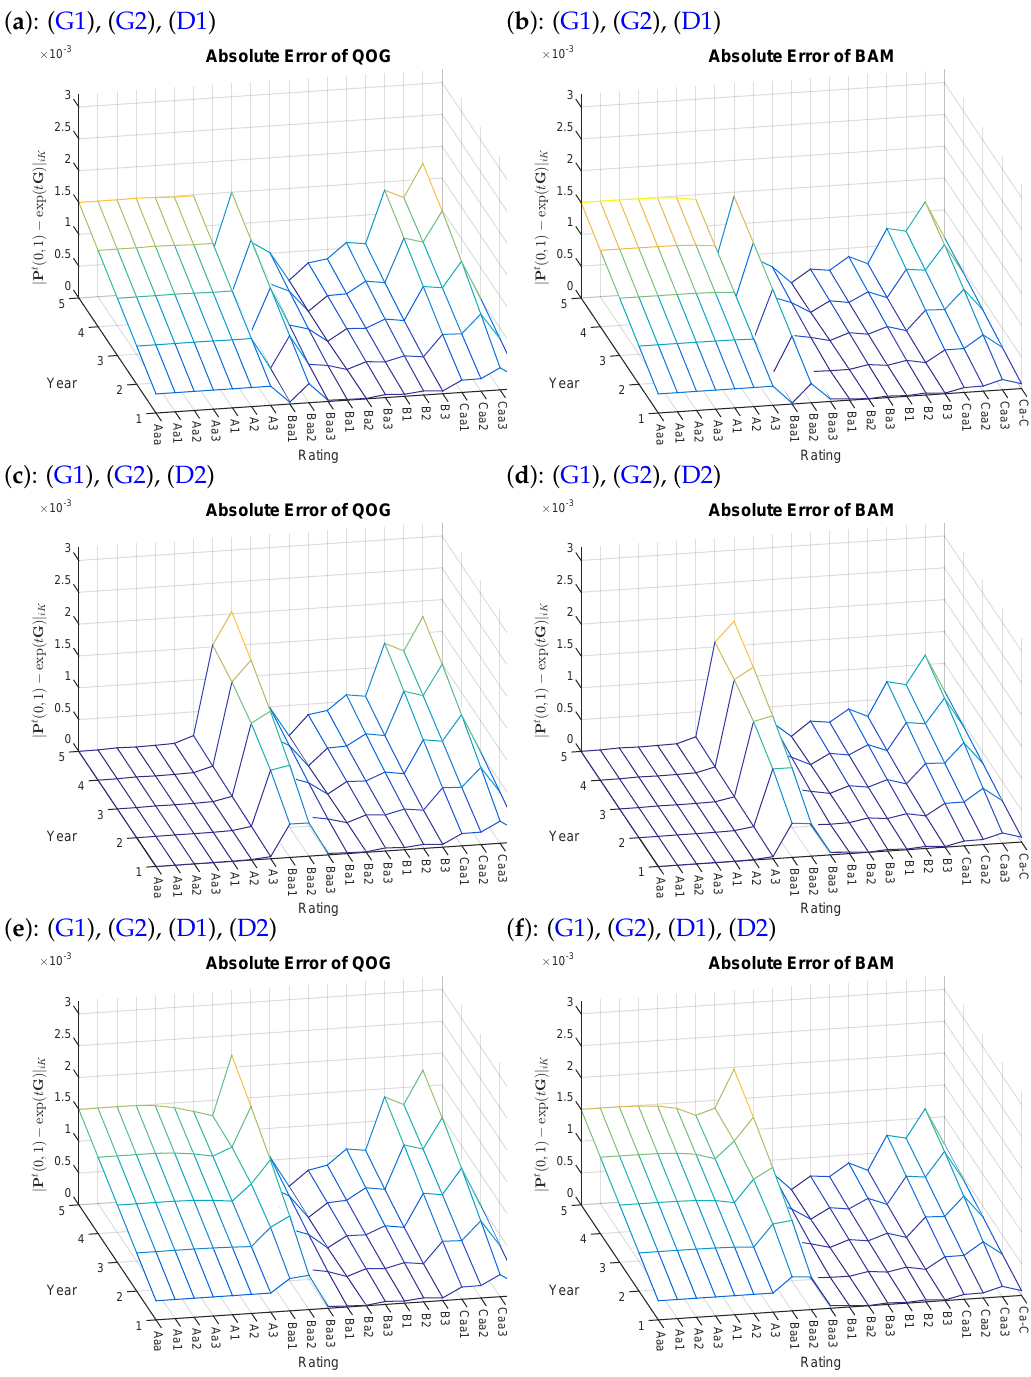
Figure 2. Absolute errors of Problems QOG and BAM based on various additional constraints with starting point X DMPG , for transition matrix P Moodys XXL ( 0,1 ) in Table A1. Left side: ( a , c , e ) QOG; right 0 side: ( b , d , f )